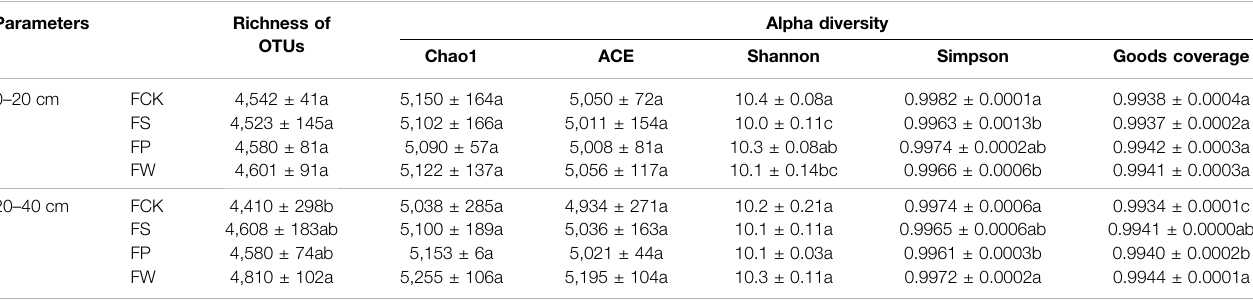
TABLE 2 | Impacts of vegetation species on the richness of OTU and alpha diversity